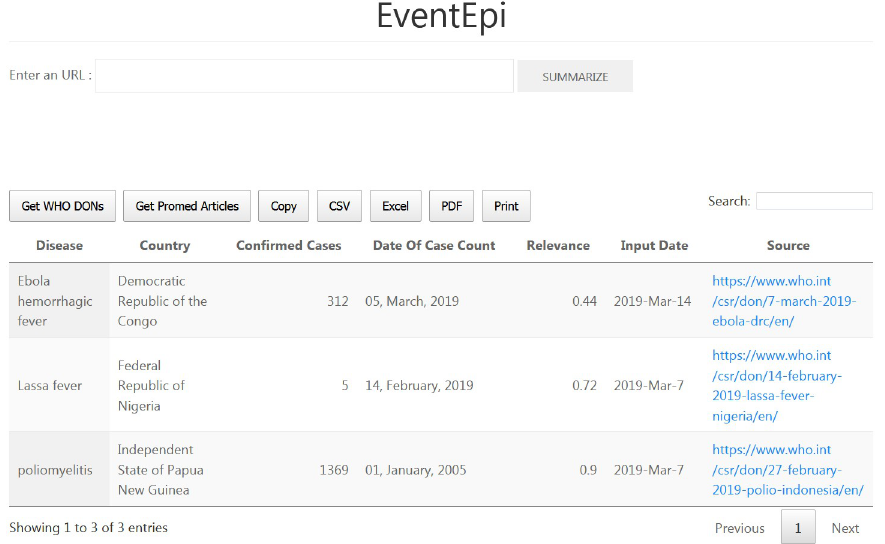
Fig 3. A screenshot of the EventEpi web application. The top input text field receives an URL. This URL is summarized if the SUMMARIZE button is pushed. The result of this summary is entered into the datatable, which is displayed as a table. The buttons Get WHO DONs and Get Promed Articles automatically scrape the last articles form both platforms that are not yet in the datatable. Furthermore, the user can search for words in the search text field and download the datatable as CSV, Excel or